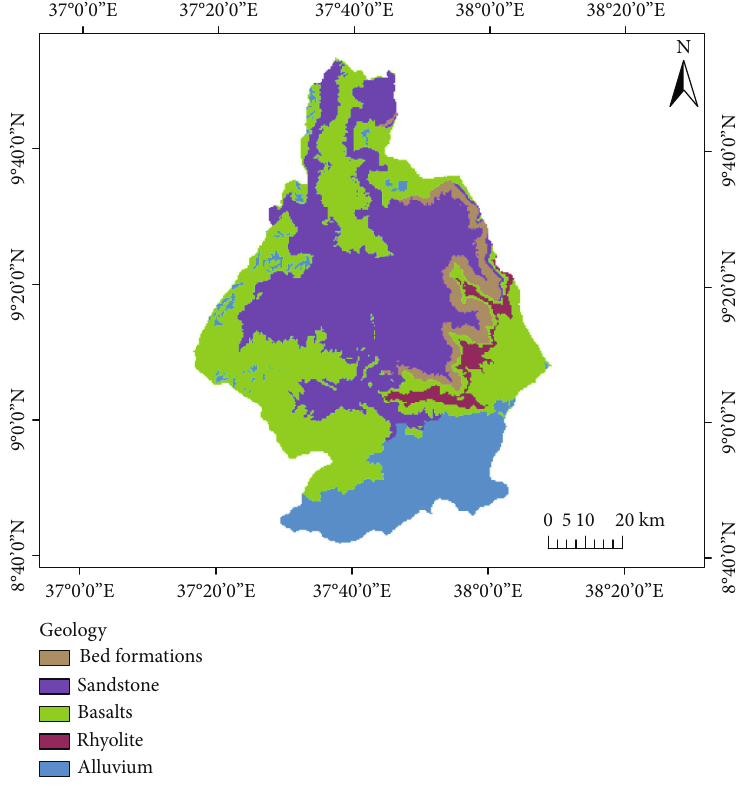
Figure 6: Geology of Guder watershed.